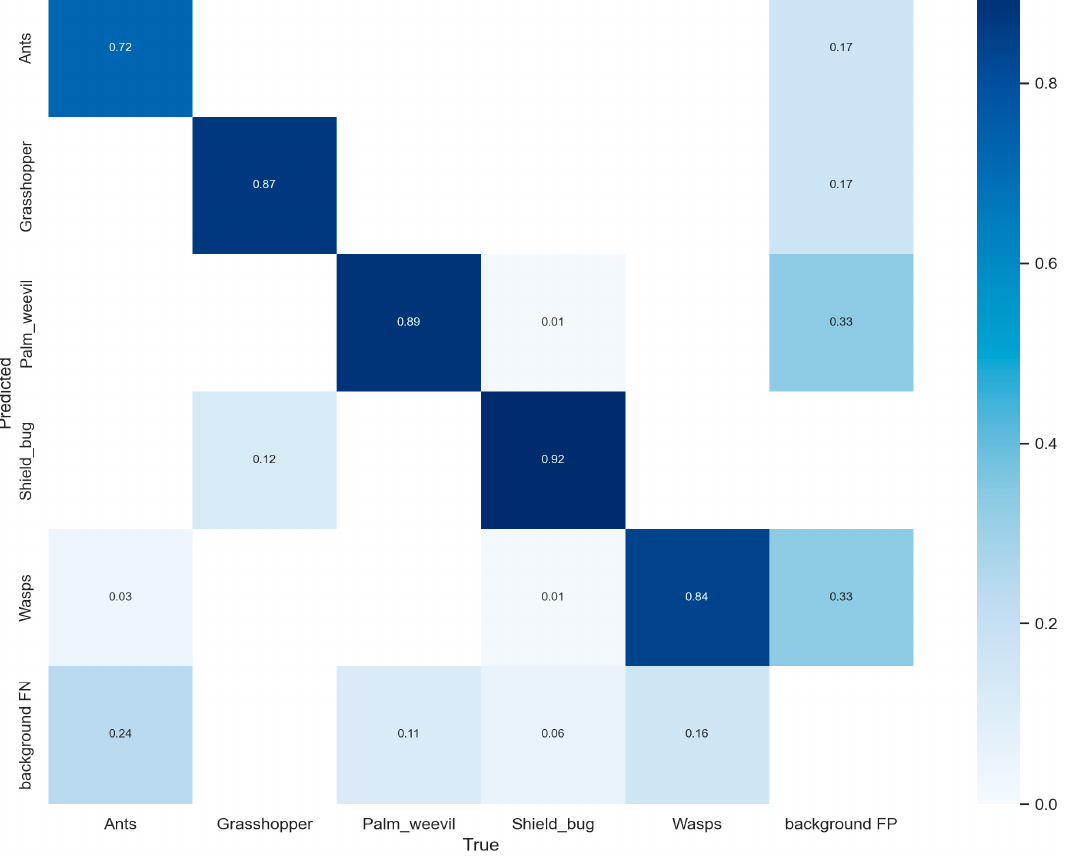
Figure 7. represents the confusion matrix of the proposed model using a self ‐ created